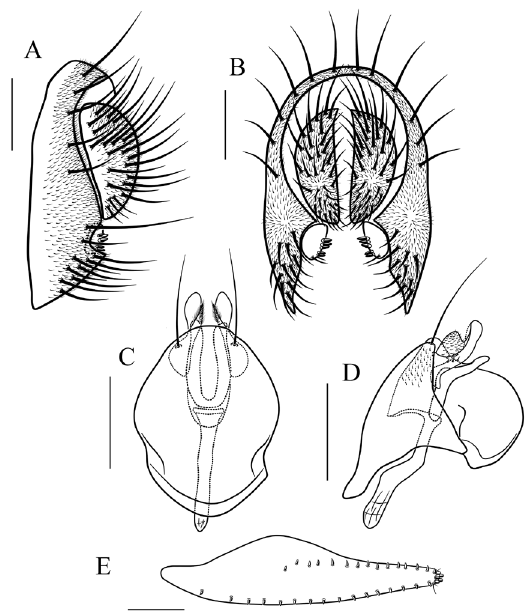
Figure 17. Scaptodrosophila rhina sp. n. A, B epandrium, surstylus and cercus (lateral and posterior views) C, D hypandrium, parameres, gonopods, aedeagus and aedeagal apodeme (ventral and lateral views) E oviscapt (lateral view). Scale bars 0.1